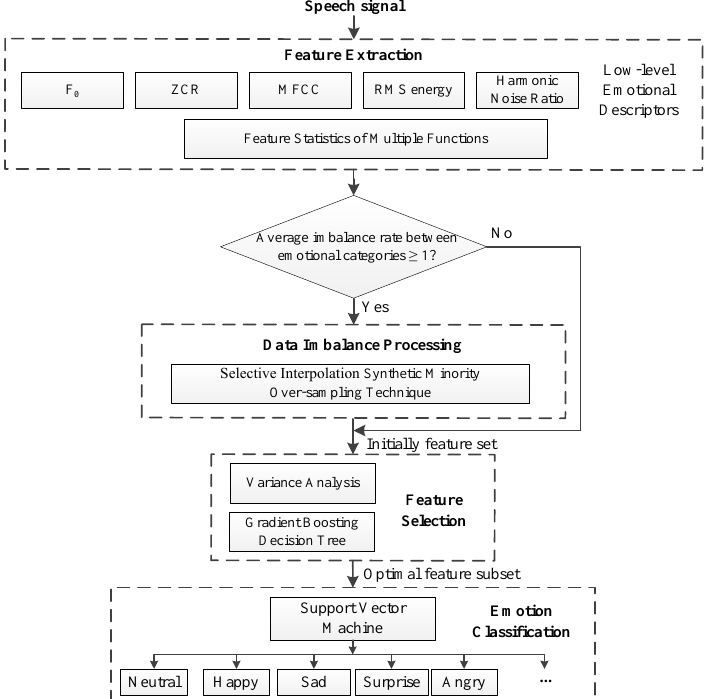
Figure 1. Flowchart of the proposed speech emotion